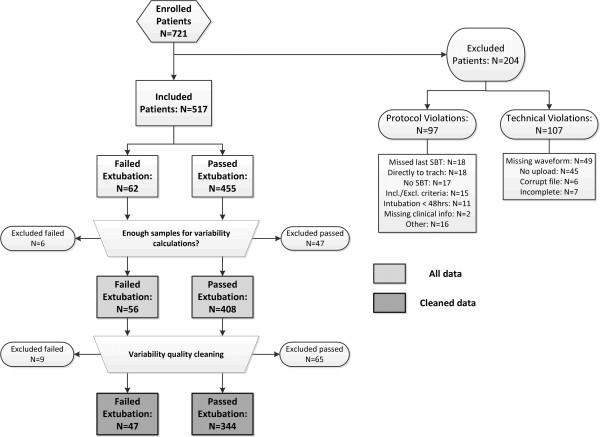
Flow diagram of selection of patients. Beside standard exclusions due to protocol and technical violations, the diagram shows how the dataset was reduced to ensure proper variability computation. In particular, patients were excluded when (1) having less than two windows of both heart rate and respiratory rate variability to analyze prior and during the spontaneous breathing trial, and (2) variability was extracted from waveforms deemed to be poor quality.